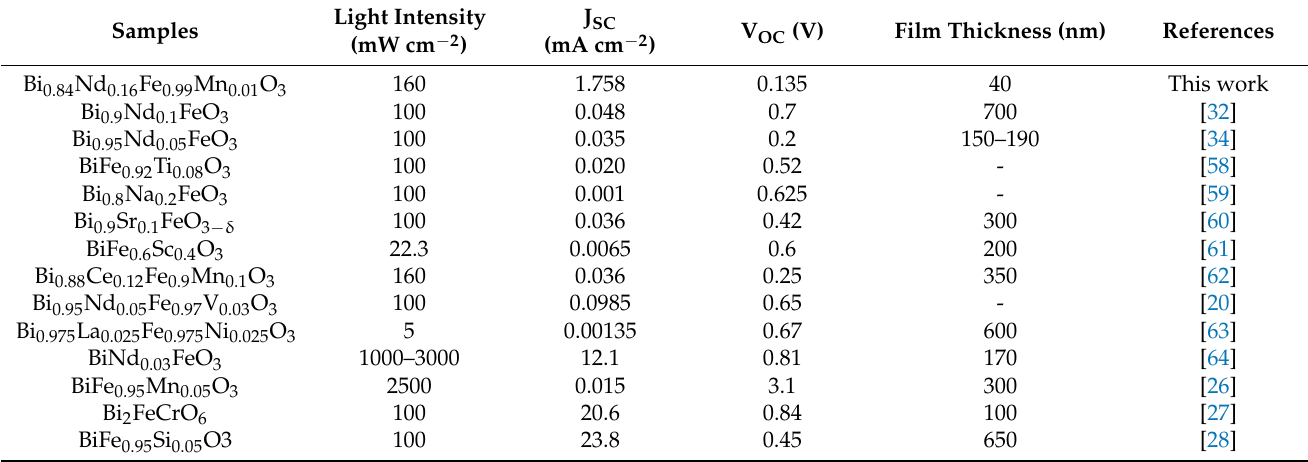
Table 1. Comparison of photovoltaic performance and thickness for doped BFO